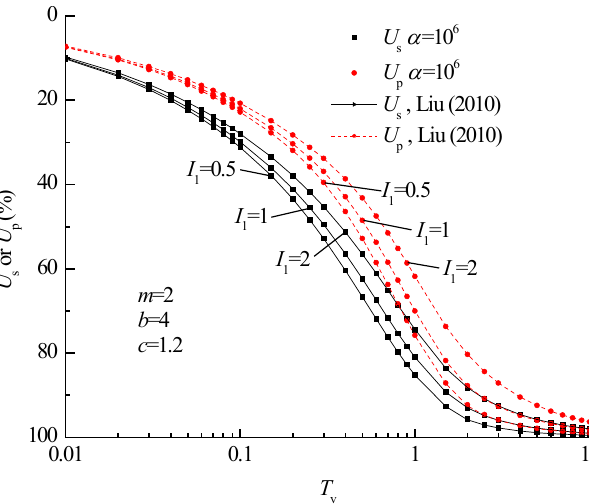
Figure 3. Comparison of ACDs obtained from different drainage boundaries [23].